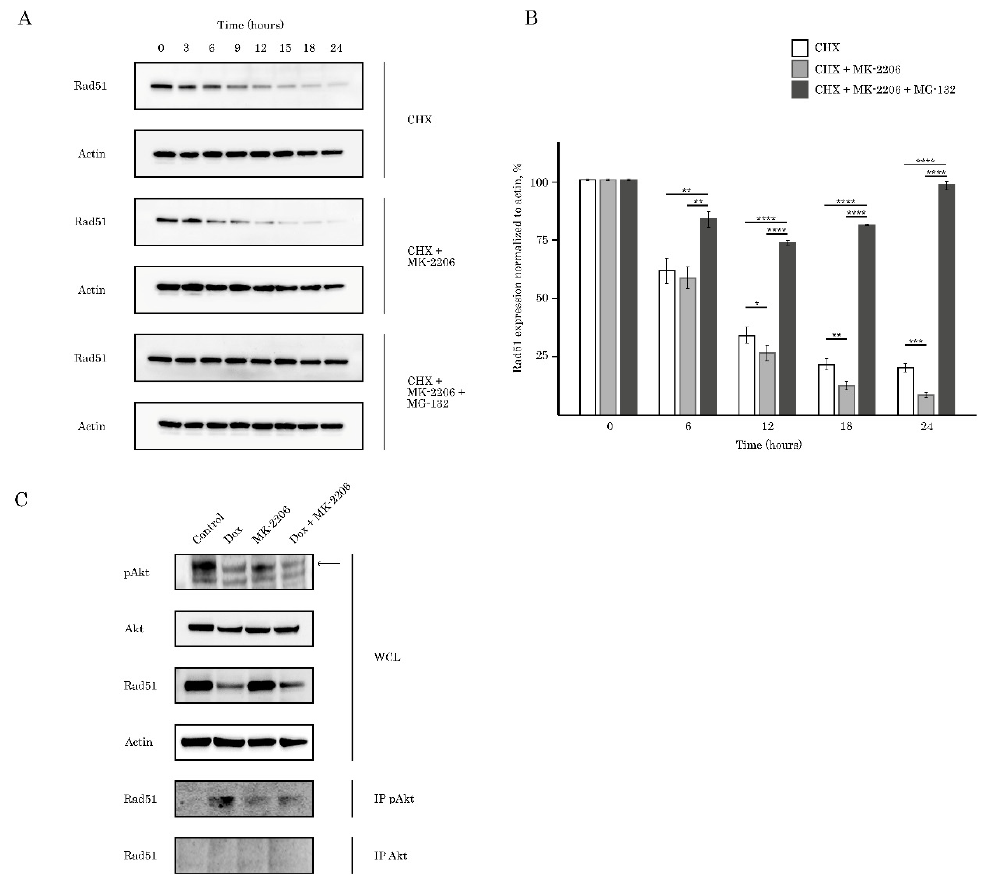
Figure 8. AKT is required for regulation of Rad51 stability . ( A ) the half-life of Rad51 was determined by cycloheximide (CHX) chase analysis. GIST T-1R cells were treated with MK-2206 (5 μ M) or DMSO (control), followed by treatment with 10 μ g/mL cycloheximide for 0, 3, 6, 9, 12, 15, 18 and 24 h. Immunoblotting for Rad51 and actin was performed on samples from all time points. To examine an impact of AKT-inhibition on proteasomal degradation of Rad51, cells were treated with MK-2206 and CHX in presence of MG-132 (2 μ M) and were subjected for immunoblotting for Rad51 and actin as a loading control. ( B ) densitometric analysis of Rad51 in CHX chase analysis indicated above; bars, SD. * p < 0.05; ** p < 0.01; *** p < 0.001; **** p < 0.0001. ( C ) GIST T-1R cell lysates were immunoprecipitated with total (left) or phosphorylated at Ser473 (right) AKT Abs and immunoblotted with Rad51 Abs to demonstrate endogenous complex formation. A whole cell lysate (WCL) was included. pAKT expression is shown by arrows. Actin was used as a loading control. For immunoprecipitation experiments cells were treated with Dox (1 μ g/mL) and MK-2206 (10 μ M).